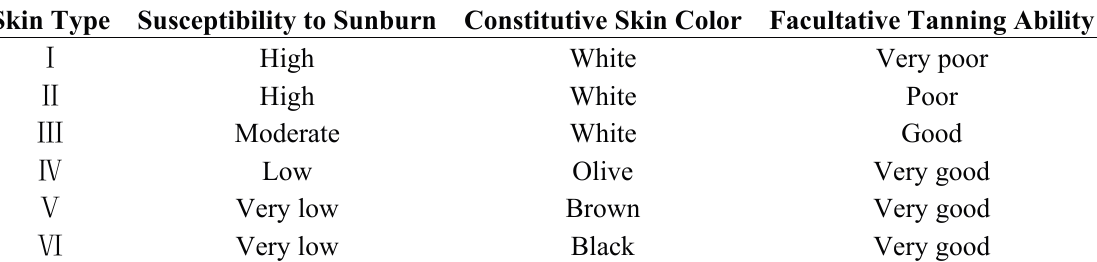
Table 1. Fitzpatrick skin type